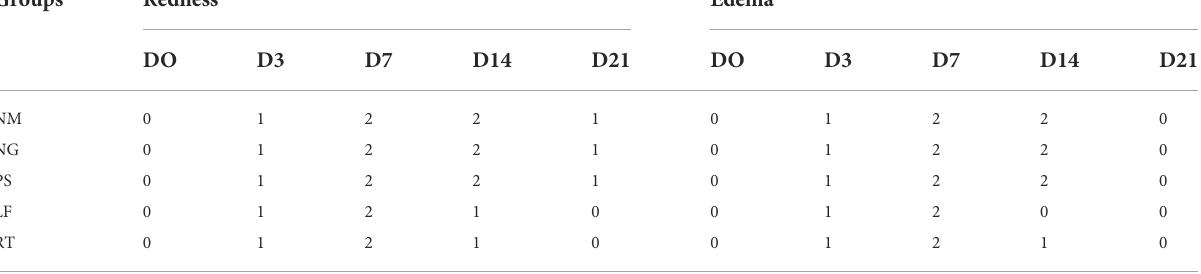
TABLE 3 Scoring from macroscopic evaluation at Day 0, 3, 7, 14, and 21. Please refer Table 1 for the scoring system. Groups